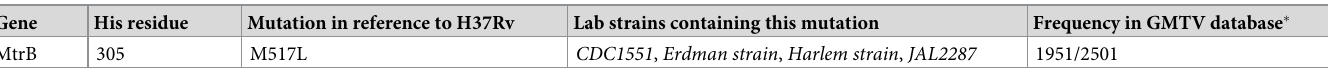
Table 1. Table shows the frequency of the mutation occurring in different strains of Mycobacterium tuberculosis and prevalence in the GMTV database. Gene His residue Mutation in reference to H37Rv Lab strains containing this mutation MtrB 305 � The GMTV database consists of 2501 clinical genome sequences that have been aligned for mutations in different regions of the bacteria.